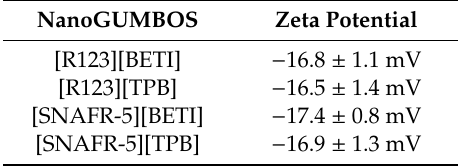
Table 1. Zeta potential of R123 and SNAFR-5